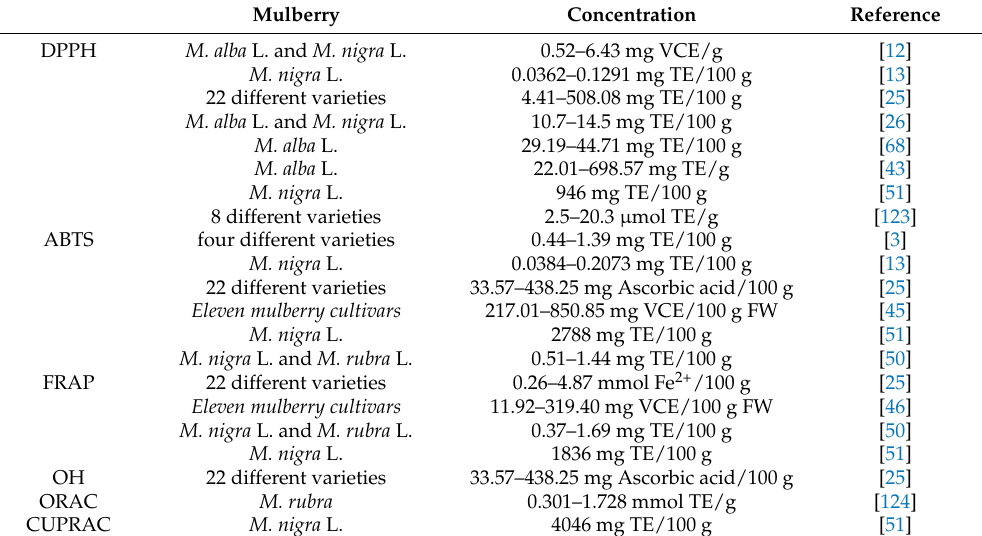
Table 4. Anti-oxidant activity of